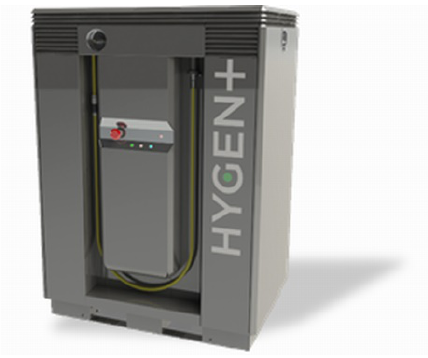
Fig. 7. VFA HYGEN + for commercial vehicle fuelling, with a boosting feature, manufactured by Hygen . It has integrated four compression cylinders 33 L each and four storage cylinders 95 L